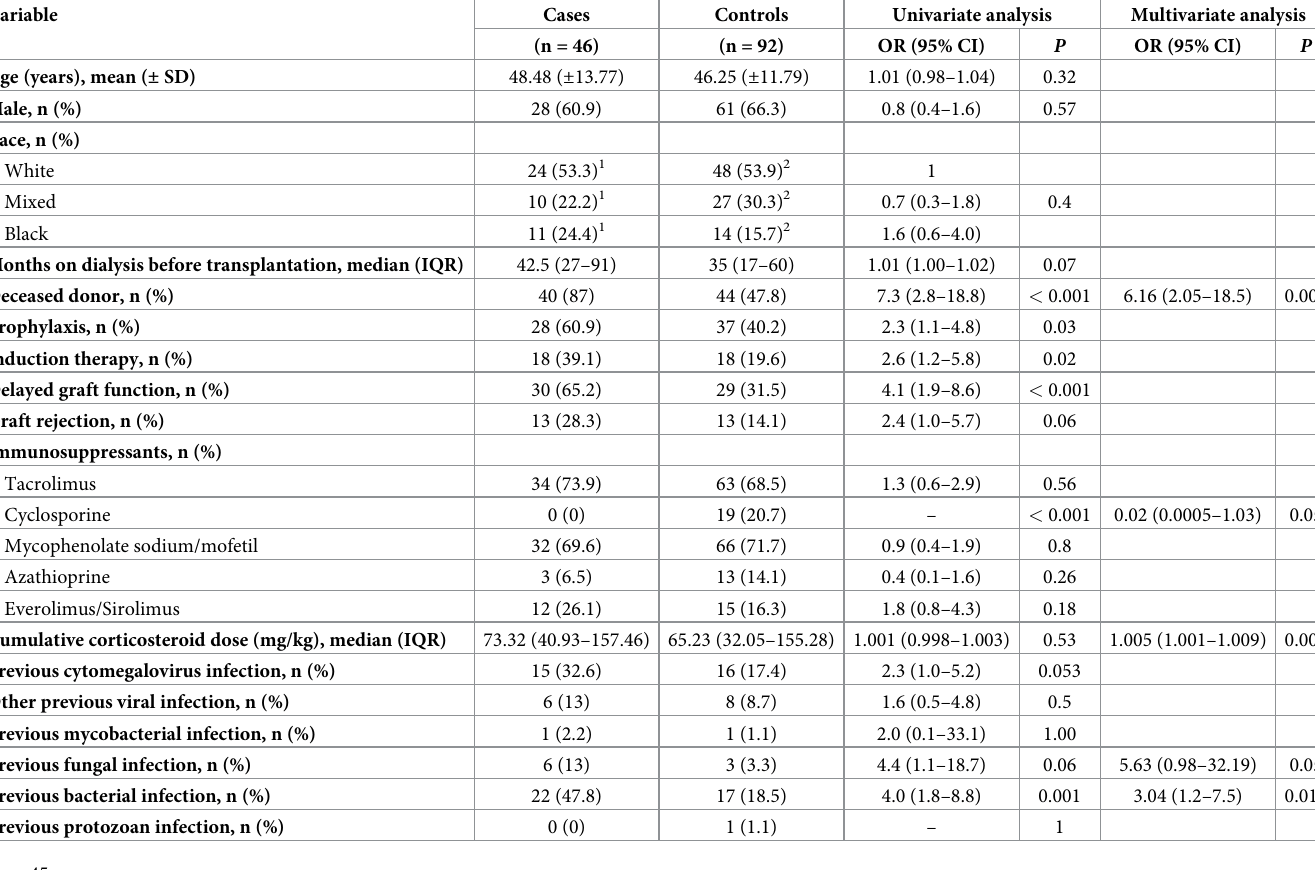
Table 5. Univariate and multivariate analyses for risk factors for severe Strongyloides stercoralis